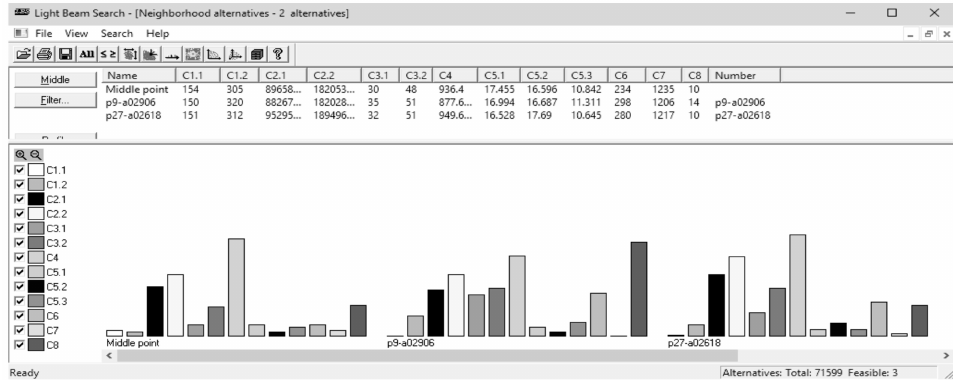
Figure 6. The visualization of results of the final LBS procedure: middle point, p9-a2906 and p27-a2618. The geographical layout of the EVCSs for both alternatives is shown in Figure 7. It varies in terms of coverage of specific parts of the city. Good geographical coverage of the whole city, including noncritical areas, would require the use of more EVCSs.